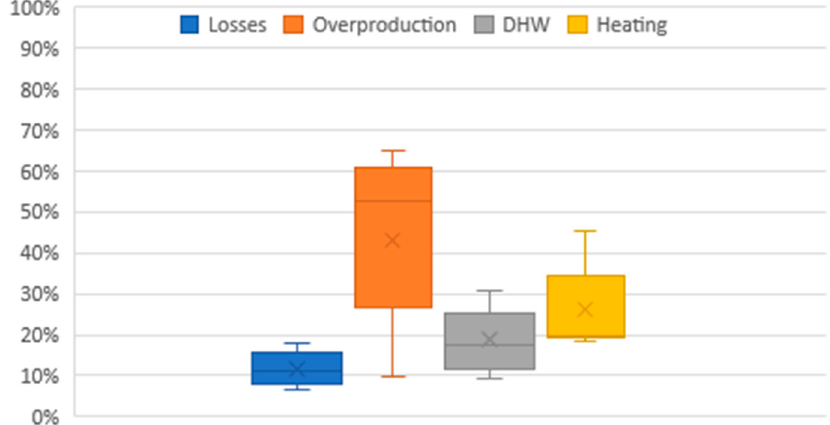
Figure 12. Box and whisker plot of the percentage of the thermal storage losses, overproduction, domestic hot water ( DHW ), and heating output with respect to the total energy input.